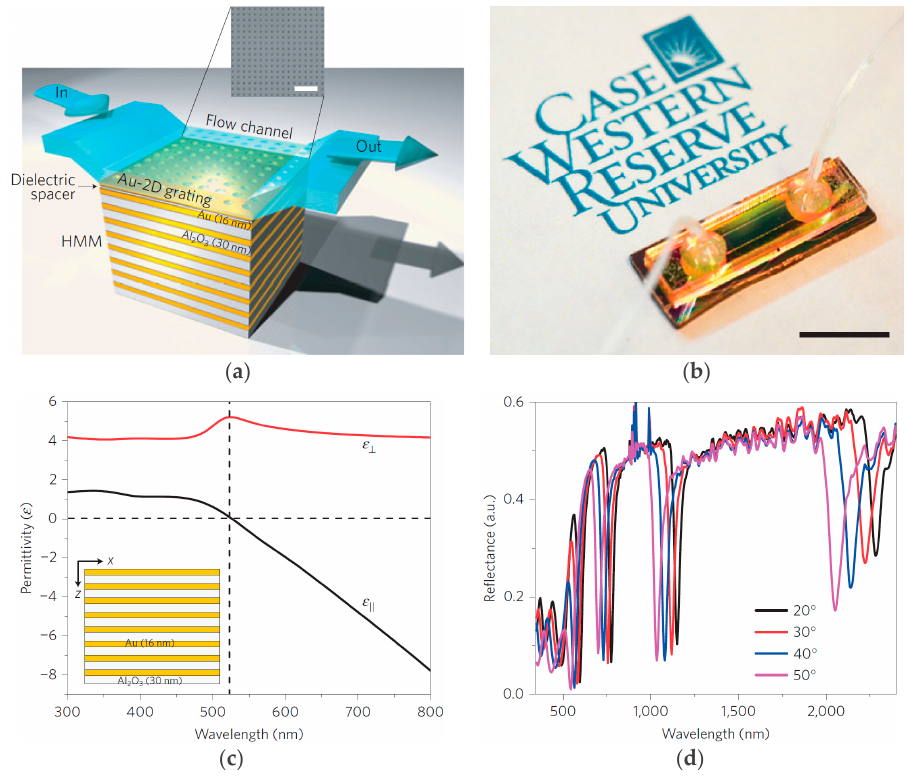
Figure 13. Hyperbolic metamaterial plasmonic biosensor integrated with microfluidics: ( a ) a 3D view of the fabricated biosensor with a fluid flow channel and a SEM image of the fabricated 2D subwavelength gold diffraction grating on top of the sensor surface; ( b ) photograph of the grating coupled hyperbolic metamaterial sensor device fully integrated with a microfluidic channel and sample tubing; ( c ) real parts of effective permittivity of biosensor, which shows a hyperbolic dispersion at λ ≥ 520 nm (dashed vertical line). In the inset the side view of fabricated biosensor is shown; and ( d ) reflectance spectra of the grating coupled HMM at different angles of incidence. It shows four prominent reflectance dips, corresponding to the bulk plasmon polariton modes, and two weak reflectance minima in the shorter wavelengths, corresponding to the SPP modes, all six modes are guided modes (redrawn from [85]).